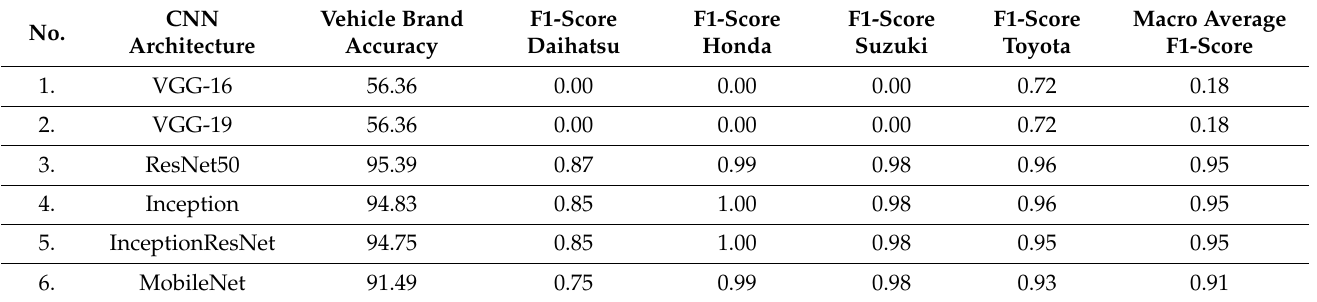
Table 3. Performance comparison for vehicle brand classification using CNN baseline architec- tures.